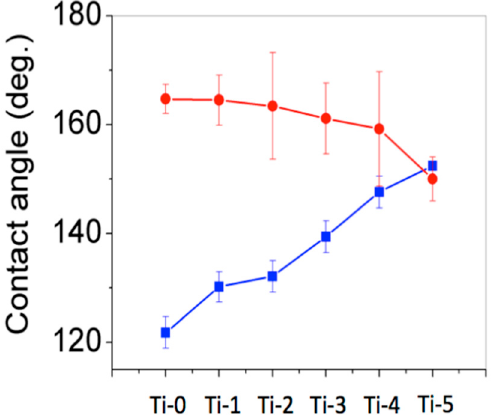
Figure 4. The water contact angle of torched-titanium substrates with various torching times. (blue square, electropolishing method; red circle, sandpaper method).